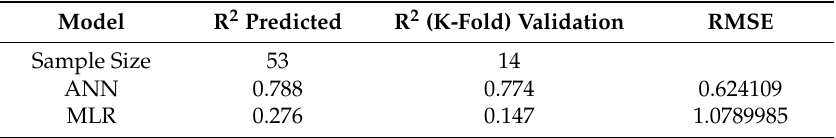
Table 6. Comparative Analysis of ANNs Vs Multiple Linear Regression (MLR).